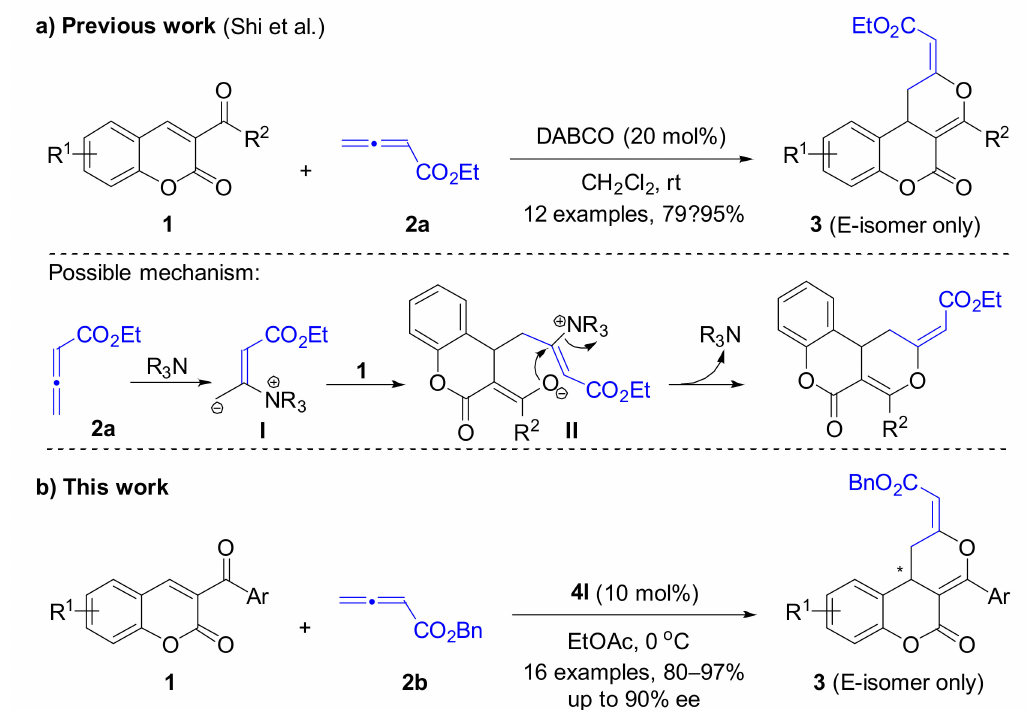
Figure 1. ( a ) DABCO catalyzed [4 + 2] cyclization of 3-aroylcoumarines with 2,3-butadienoate; ( b ) Chiral tertiary amine catalyzed [4 + 2] cyclization of 3-aroylcoumarines with